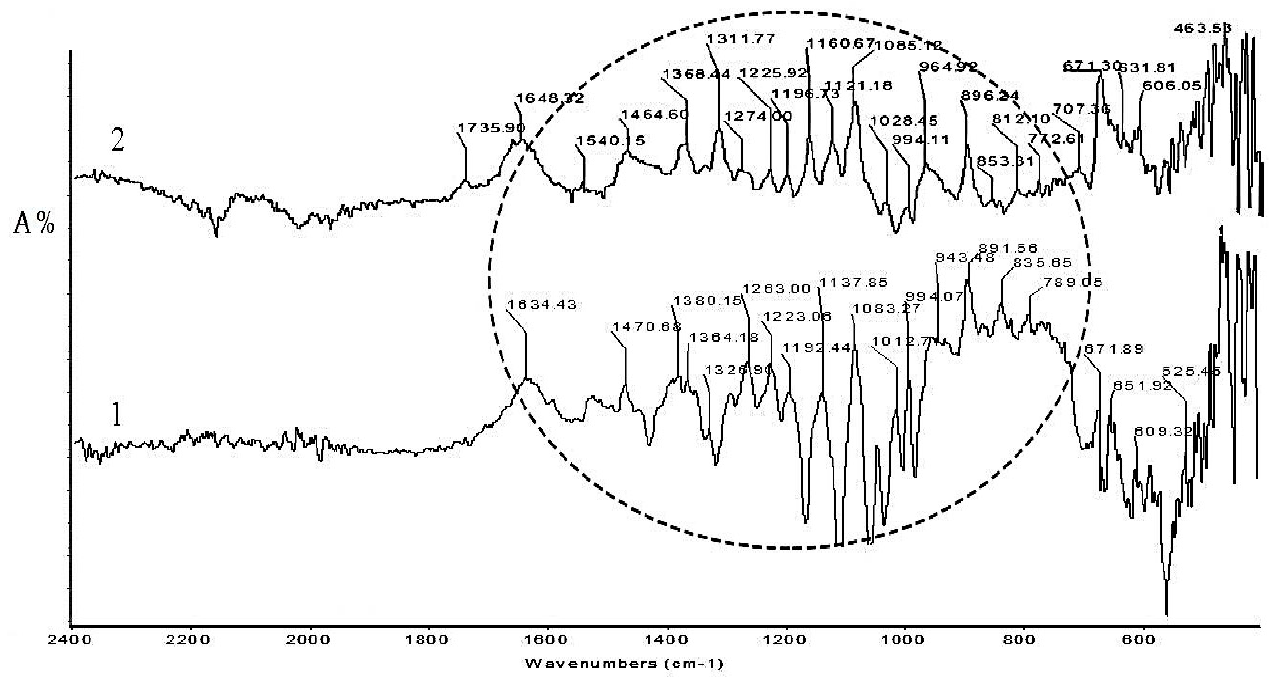
Figure 7. FTIR-ATR absorption spectra: 1- Sample 9 , 2- Sample 10.